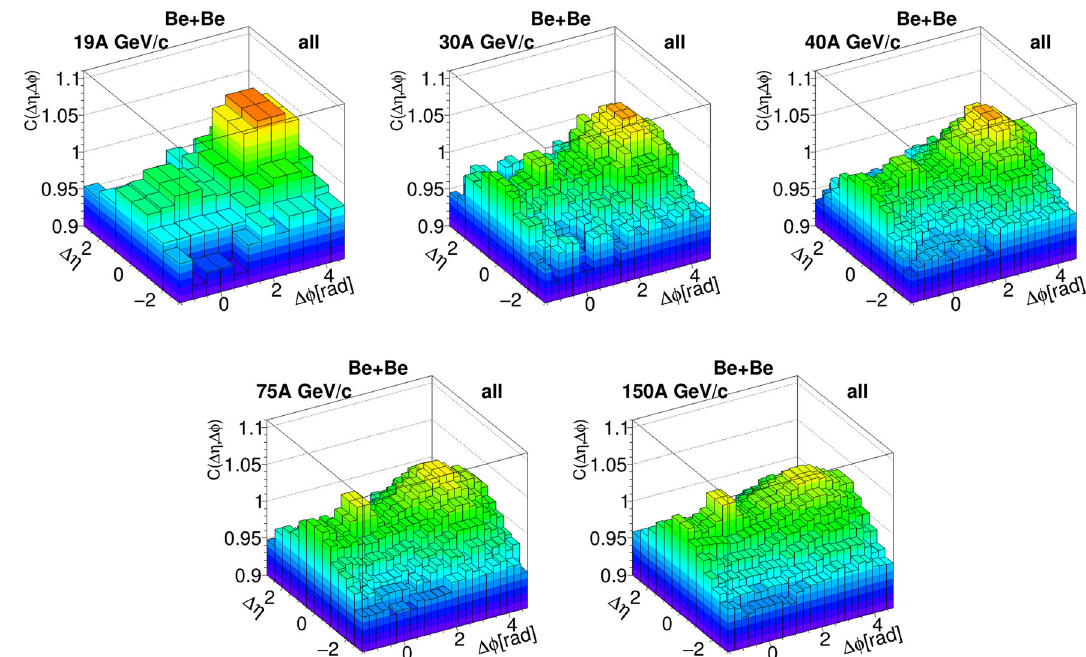
Fig. 6 Two-particle correlation function C ((cid:2)η,(cid:2)φ) for all charge pairs in the 5% most central Be + Be collisions at 19 A –150 A GeV / c